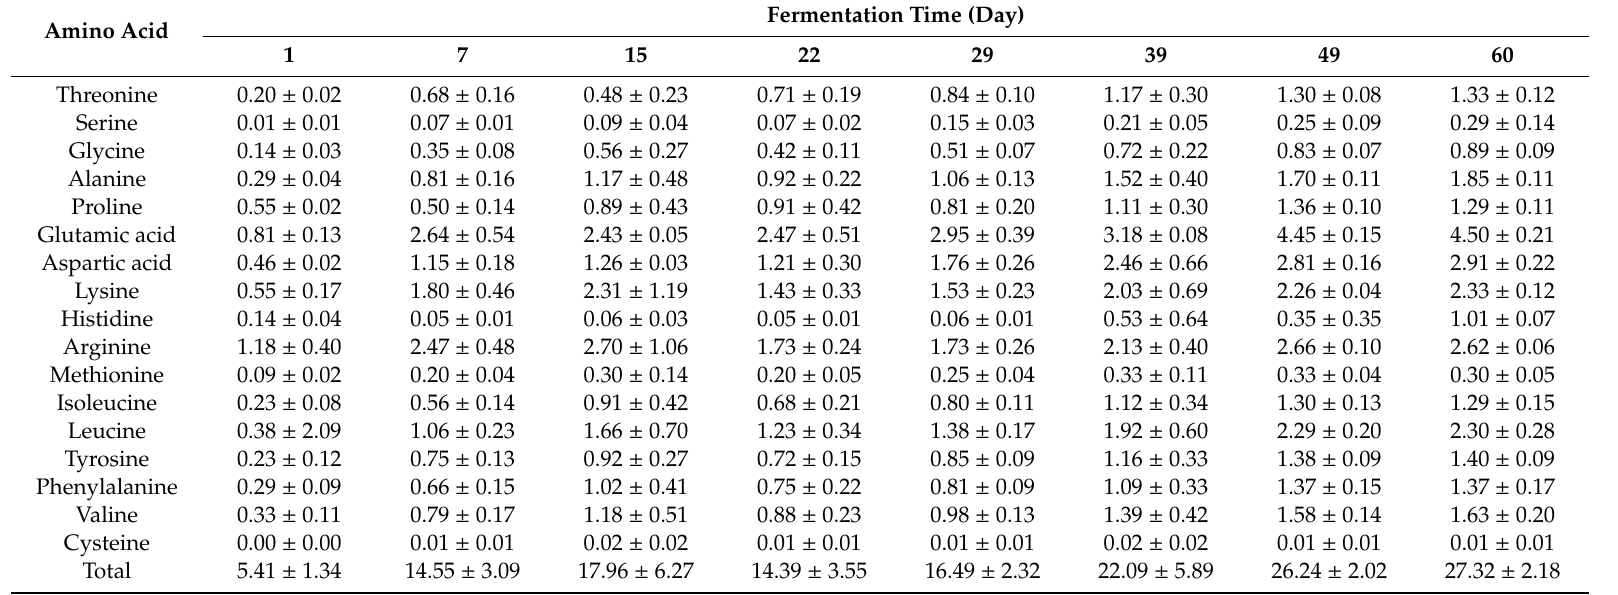
Table 2. Concentrations of amino acid in moromi samples of Pixian broad bean paste (g / kg) a